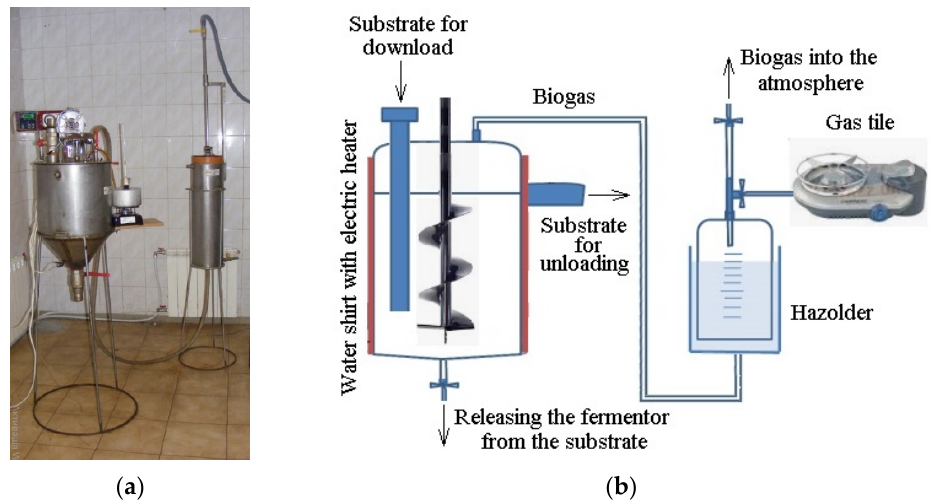
Figure 1. Laboratory biogas plant: ( a )—appearance; ( b )—plant a layout.